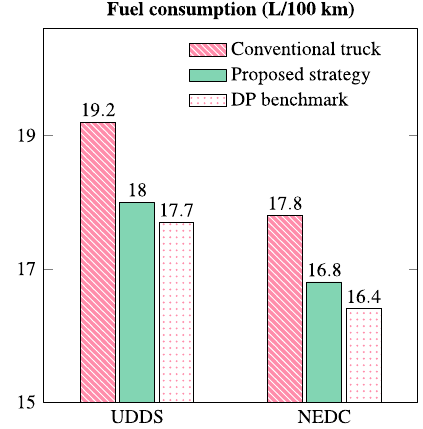
Figure 6. Comparison of fuel consumptions via simulation.